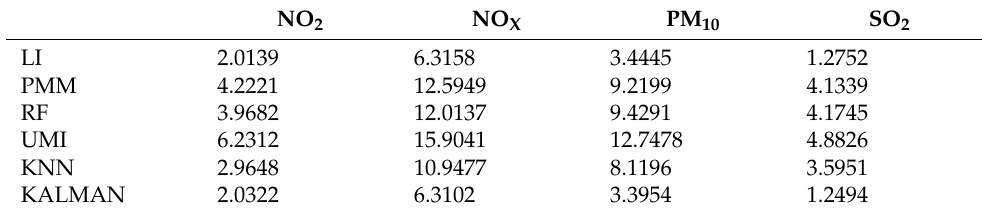
Table 4. RMSE STATION ST 1.